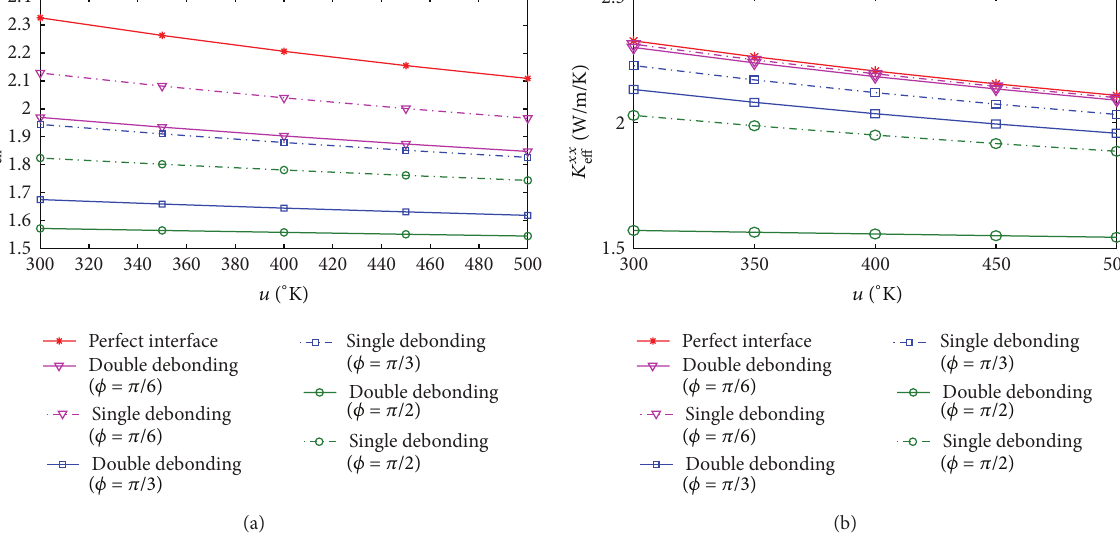
Figure6:Effectivethermalconductivityasafunctionoftemperatureanddebondingangle:(a)verticaldirection 𝐾 𝐾 𝑥𝑥 eff